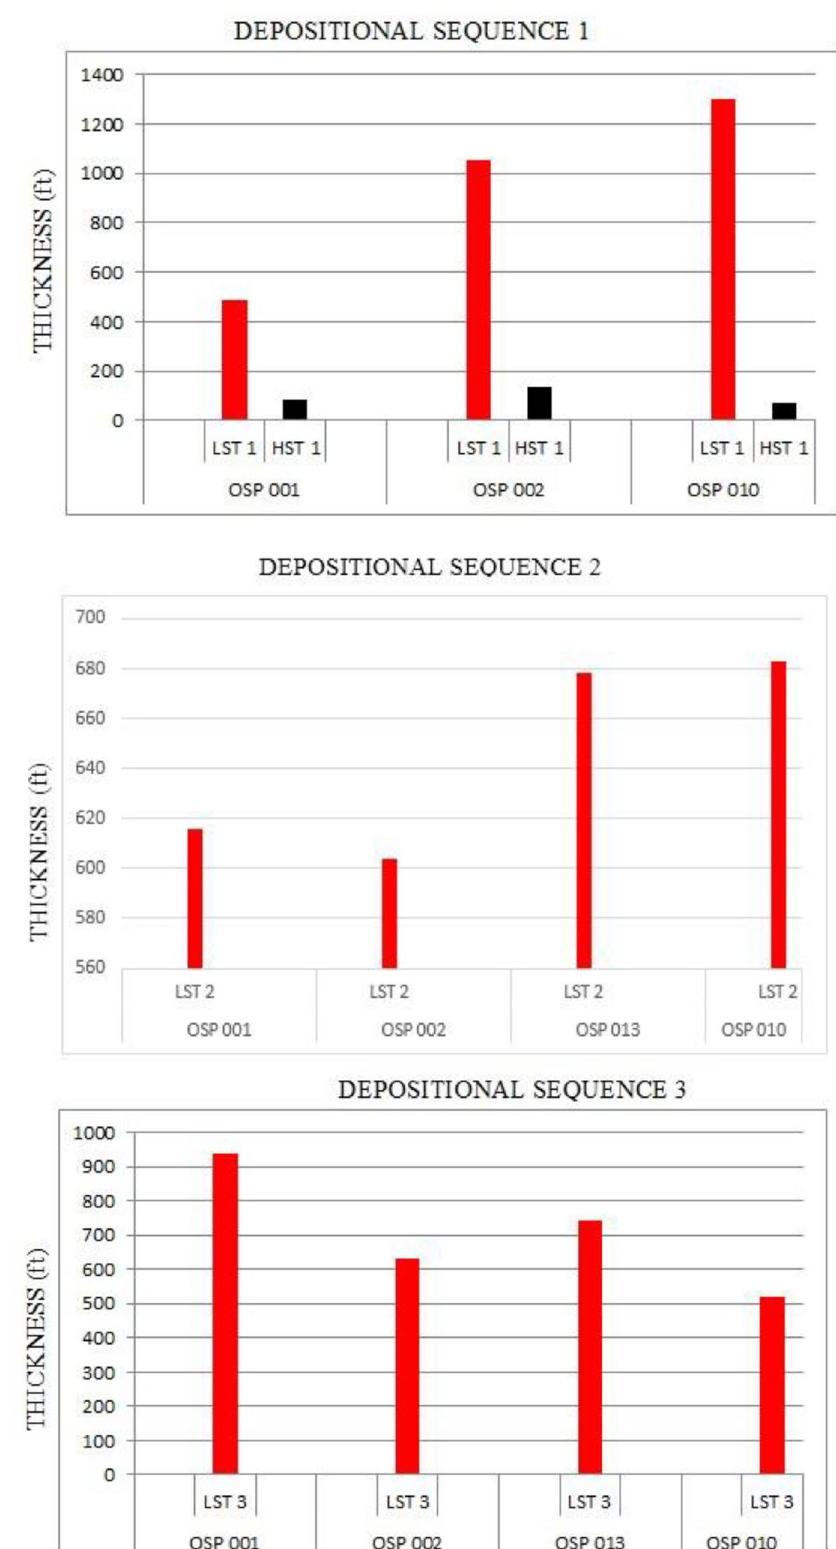
Fig. 12 Thicknesses of the systems tracts that contains